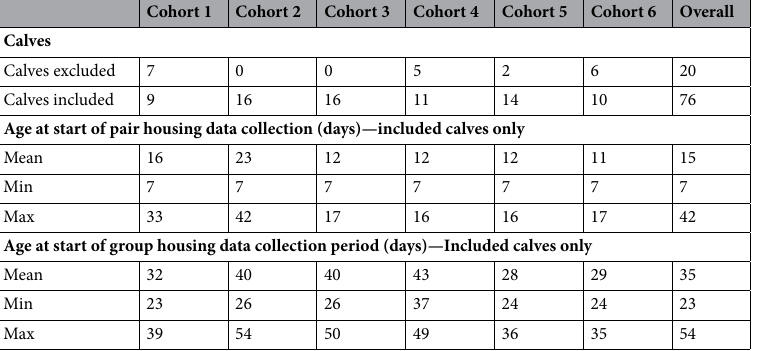
Table 1. Number of calves included in analysis per cohort as per the inclusion criteria detailed in the methods and age of calves at start of data collection.